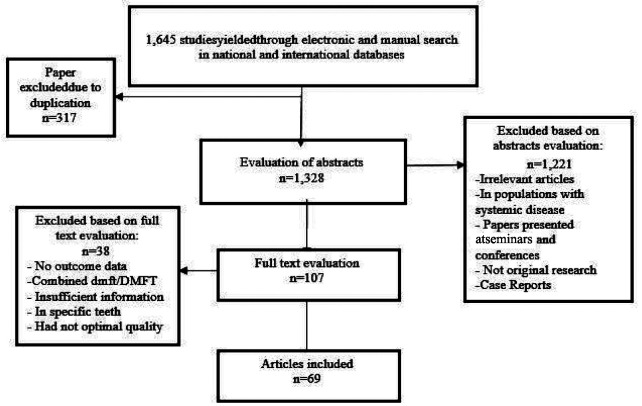
 Flow diagram of dental caries status and its related factors in Iran.